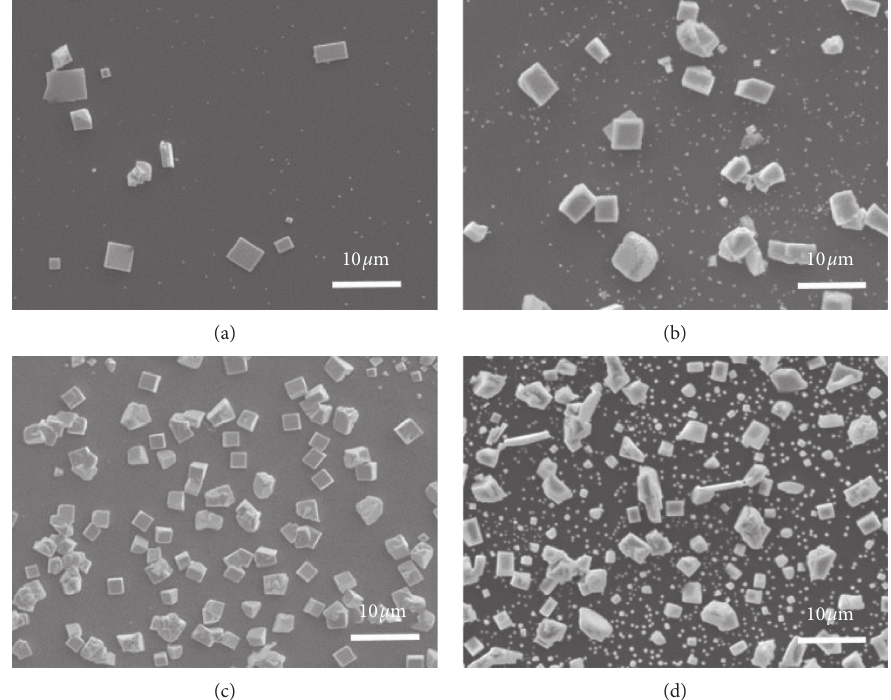
Figure 5: SEM micrographs at 5000x magnification of thin films deposited from [Pb((SeP i Pr 400 ° C, and (d) 450 °